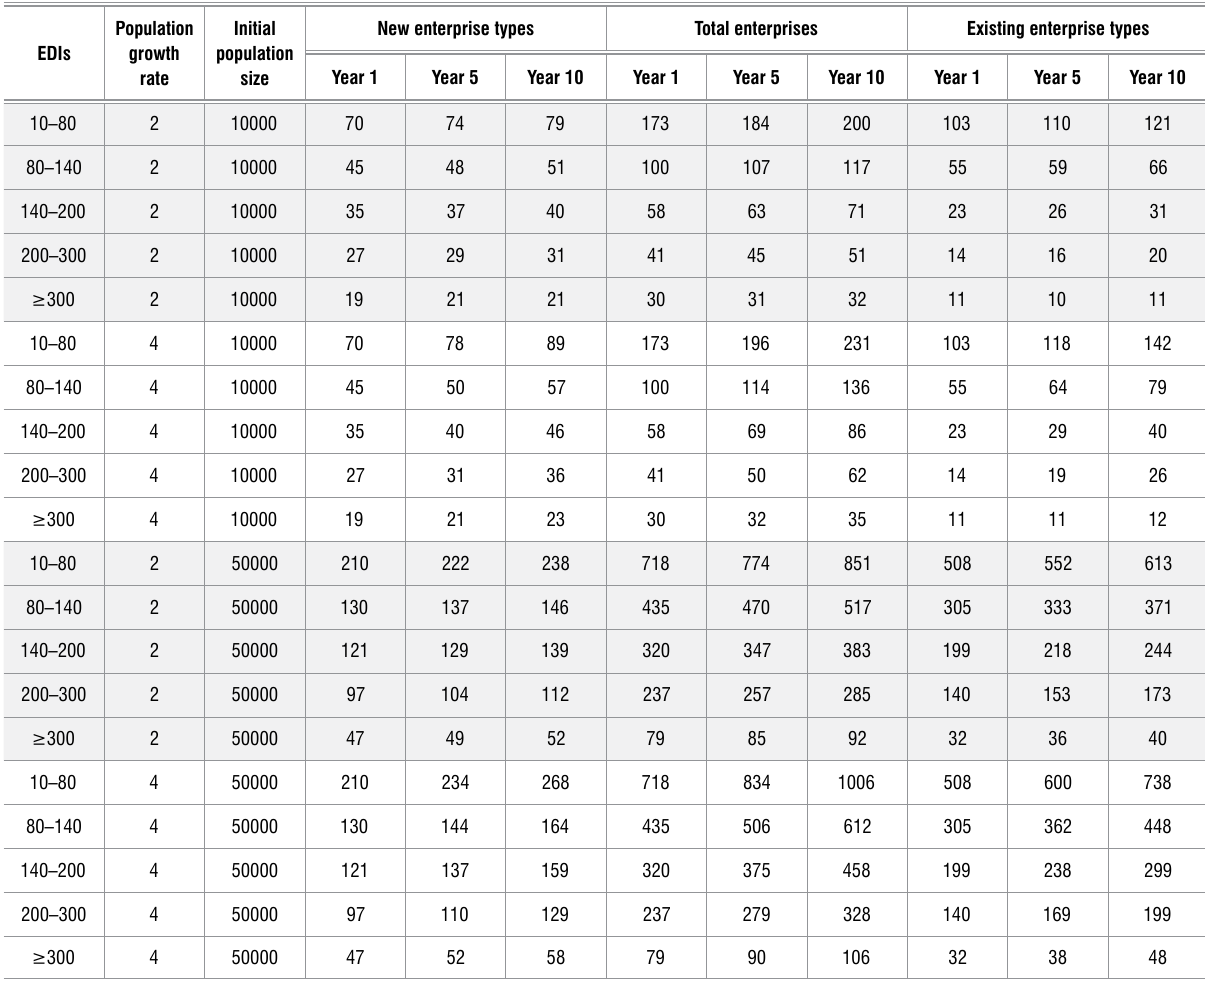
Projected increases in total enterprise numbers and the number of enterprise types in towns of two different population sizes and two different growth rates. Year 1 represents the initial conditions. Existing enterprise types = the difference between total enterprise numbers and the number of enterprise types. Higher Enterprise Dependency Indices (EDI) indicate higher poverty